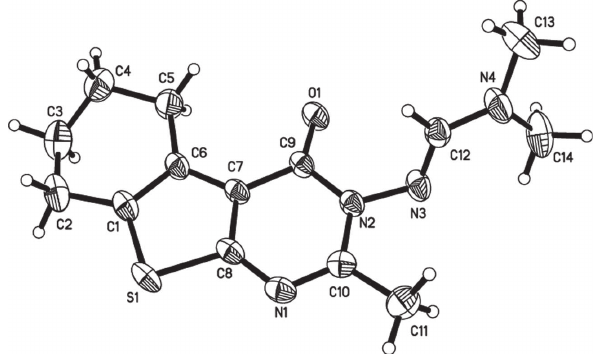
Table 1: Data collection and